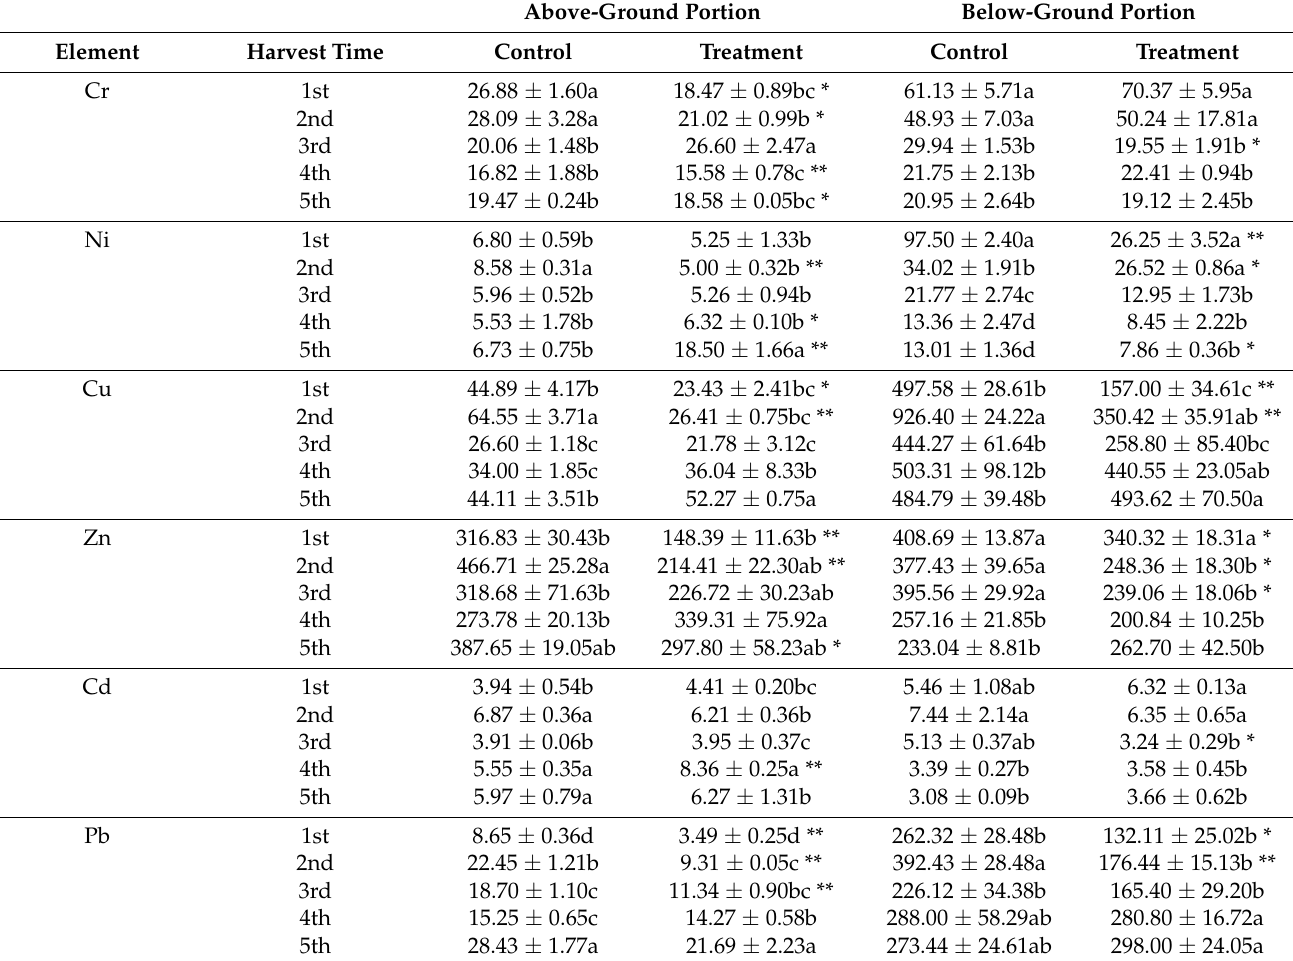
Table 2. Concentrations (mg/kg) of various heavy metals in the above-ground and below-ground parts of Gynura cusimbua in the growth experiment. Above-Ground Portion Below-Ground Portion Treatment Control